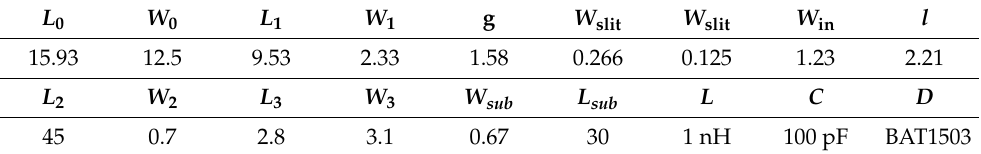
Figure 11. The proposed harvesting solution ( a ) as compared with a reference harvesting solution ( b ). The calculated final values for the parameters are reported in Table 2. Table 2. List of the geometric parameters of the antenna design. All dimensions are in